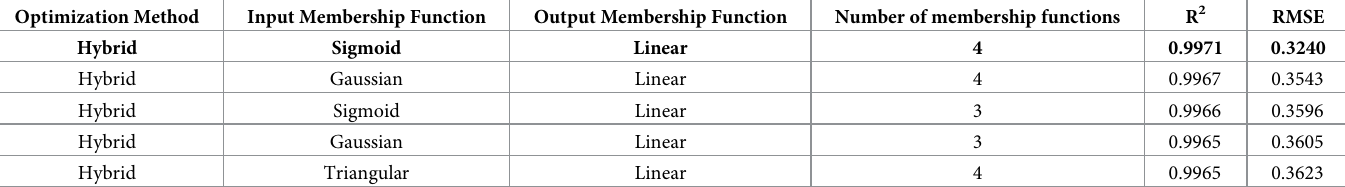
Table 9. Performance criteria of the five most accurate ANFIS structures trained with 2019 data for LA estimation. Optimization Method